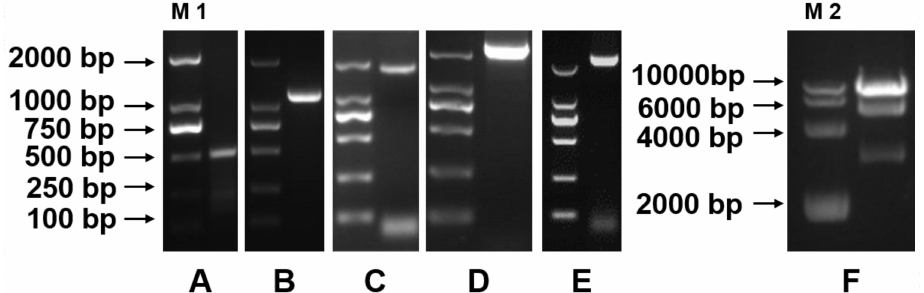
Figure 1. The cloning of pig LGR5 ( A – D ) and the identification of the recombinant plasmid LGR5 -pcDNA3.1 ( E , F ). M 1: DNA Marker 2000. M 2: DNA Marker 10,000. ( A ) 3 (cid:48) end fragment; ( B ) LGR5 A fragment; ( C ) LGR5 B fragment; ( D ) LGR5 ORF; ( E ) PCR identification of the recombinant plasmid LGR5 -pcDNA3.1; ( F ) enzyme-digesting identification of the recombinant plasmid LGR5 -pcDNA3.1